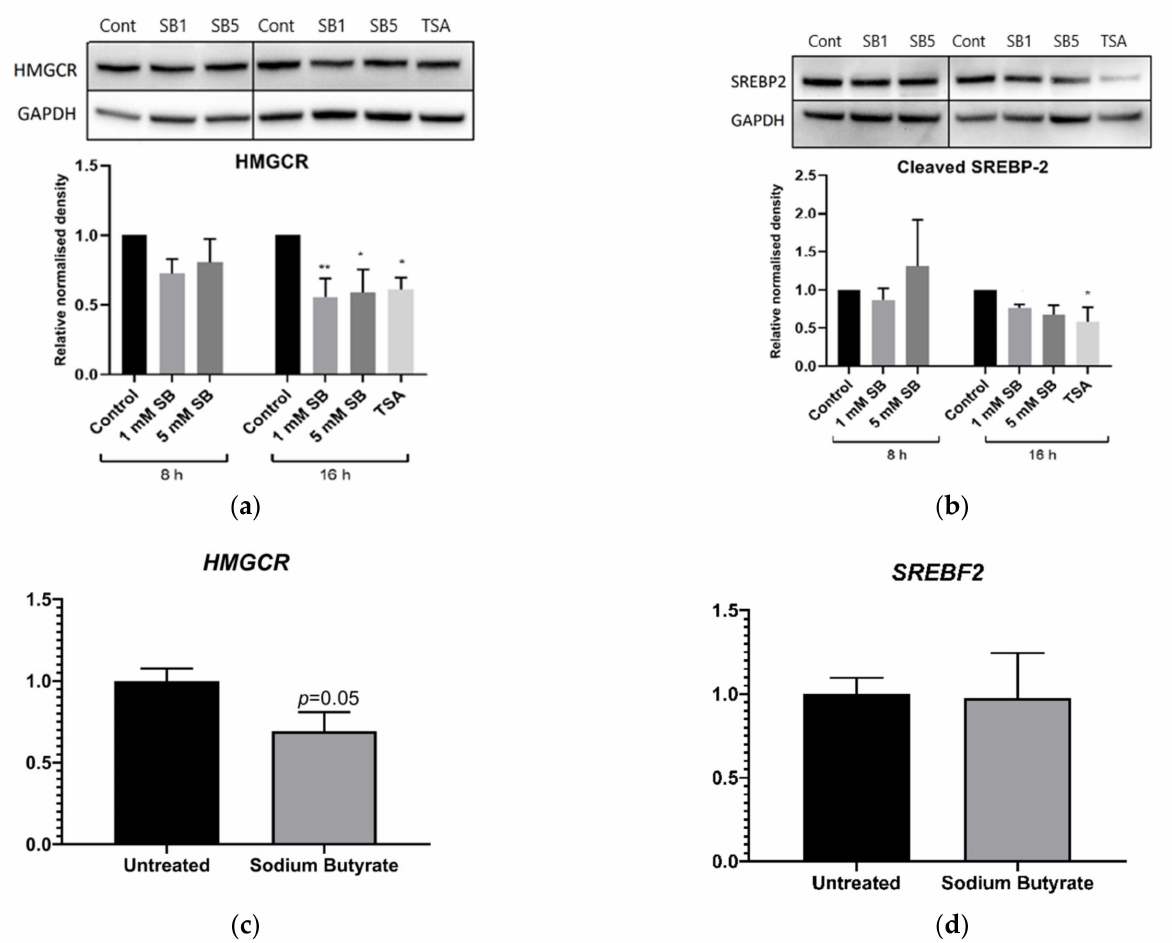
Figure 7. Influence of 8 and 16 h HDAC inhibition on cleaved SPREPB-2, HMGCR and SREBF2 and HMGCR mRNA expression in HepG2 cells. In contrast to 24 h exposure, 16 h exposure to